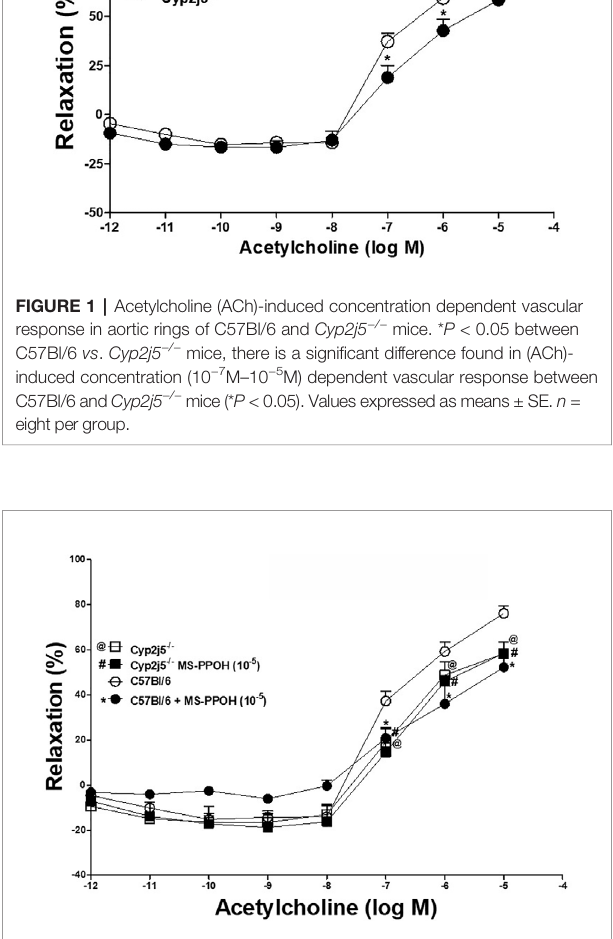
FIGURE 2 | Effect of MS-PPOH (10 − 5 M) on ACh-induced concentration dependent vascular response in aortic rings of C57Bl/6 and Cyp2j5 − / − mice. * P < 0.05 between non-treated C57Bl/6 vs . MS-PPOH treated C57Bl/6 mice, @ P < 0.05 between non-treated C57Bl/6 vs . non-treated Cyp2j5 − / − mice, # P < 0.05 between non-treated C57Bl/6 vs . MS-PPOH-treated Cyp2j5 − / − mice. #@ P > 0.05 between non-treated Cyp2j5 − / − and MS-PPOH treated Cyp2j5 − / − mice and between MS-PPOH treated Cyp2j5 − / − vs . MS-PPOH treated C57Bl/ 6 mice ( #* P > 0.05). Values expressed as means ± SE. n = eight per group.